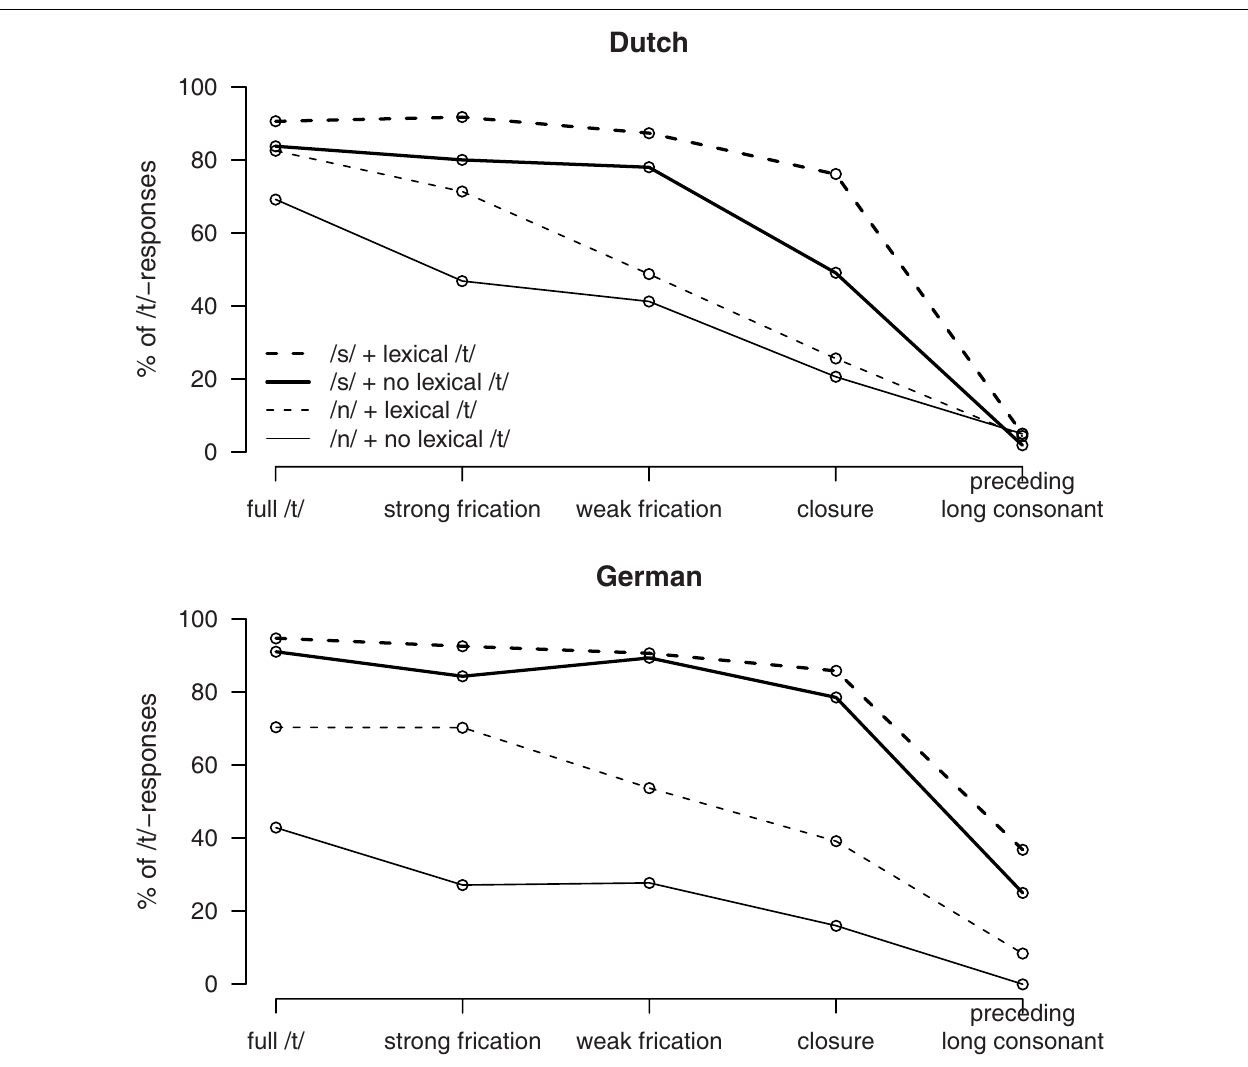
FIGURE 3 | Percentages of /t/-responses in Experiment 2 by Dutch listeners (upper panel) and German listeners (lower panel), depending on /t/-realization ( x -axis) as well as lexical status and phonological context (different